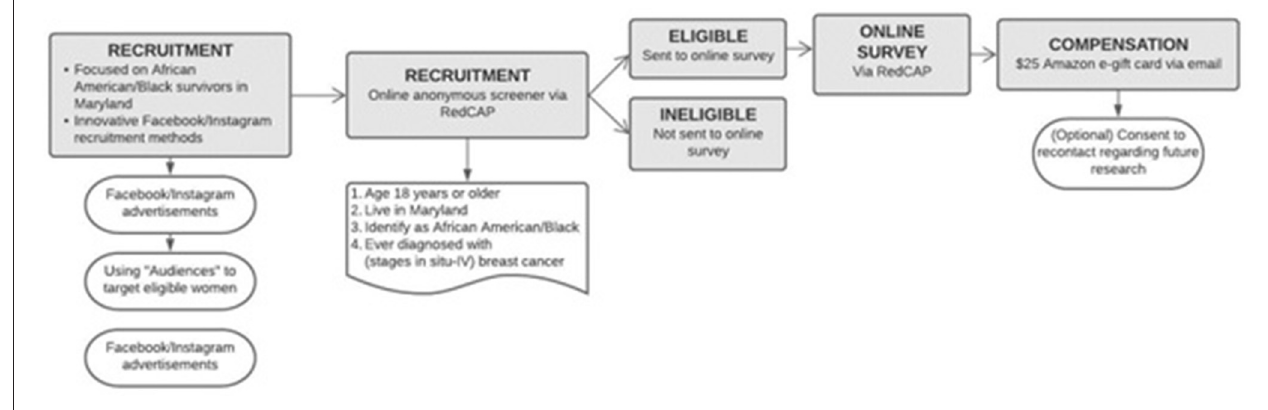
FIGURE 1 | Study Procedures.